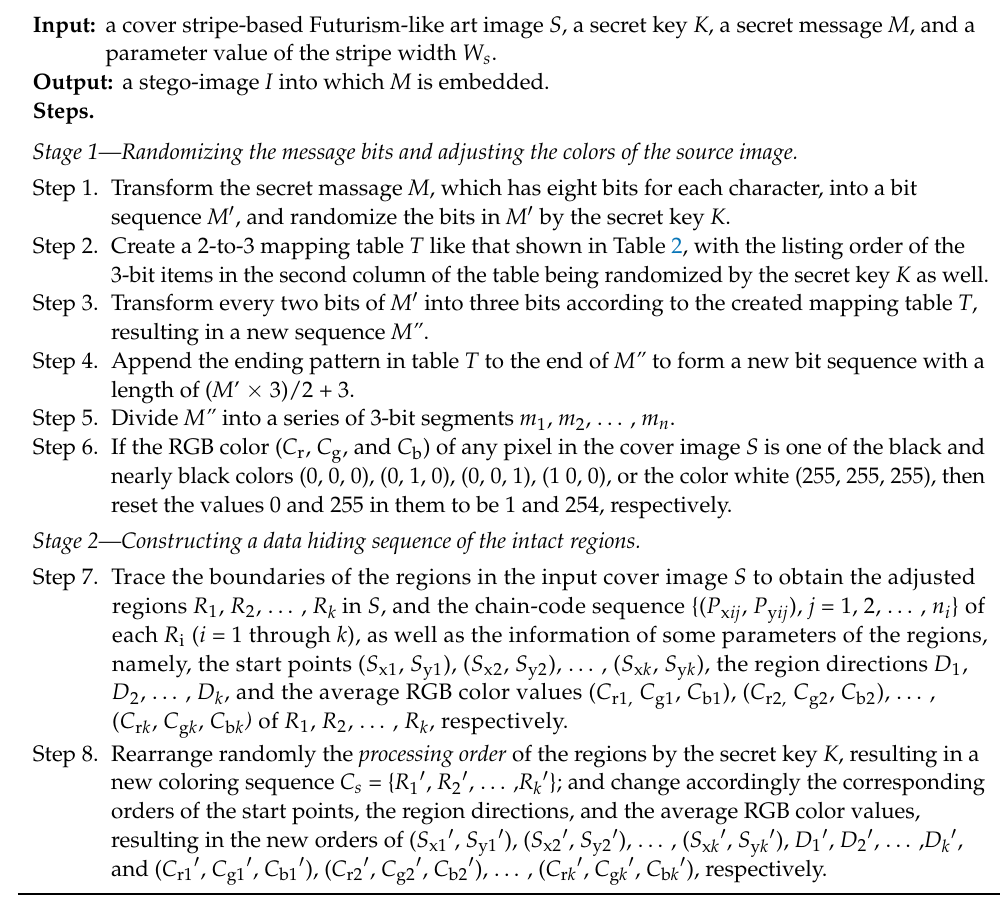
Algorithm 2. Embedding a secret message into a stripe-based Futurism-like art